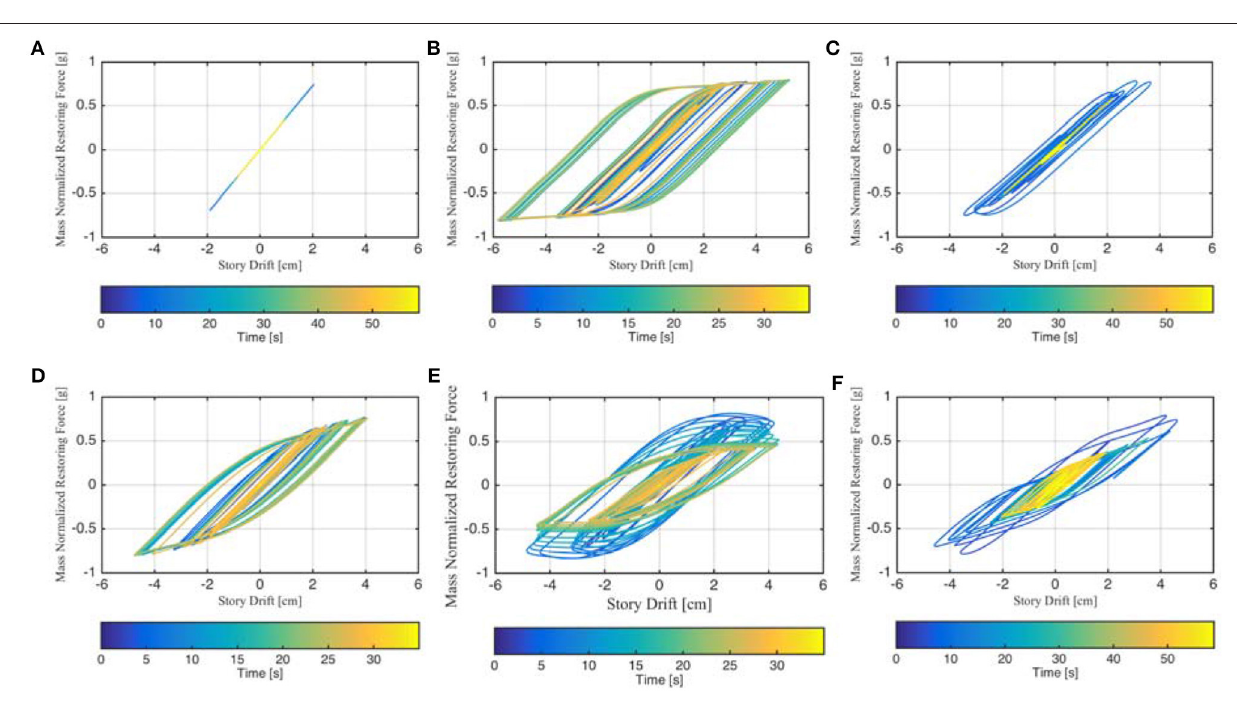
FIGURE 9 | Mass-normalized restoring force vs. story drift. (A) Linear elastic model excited by 1940 El Centro record. (B) Inelastic model with no degradation in stiffness or in strength excited by harmonic base motion (representing non-linear behavior of structural steel). (C) Inelastic model with no degradation in stiffness or strength excited by 1940 El Centro record (representing non-linear behavior of structural steel). (D) Inelastic model representing non-linear behavior of the reinforced concrete excited by harmonic base motion. (E) Inelastic model with degradation in both stiffness and strength excited by harmonic base motion. (F) Inelastic with degradation in strength model excited by 1940 El Centro